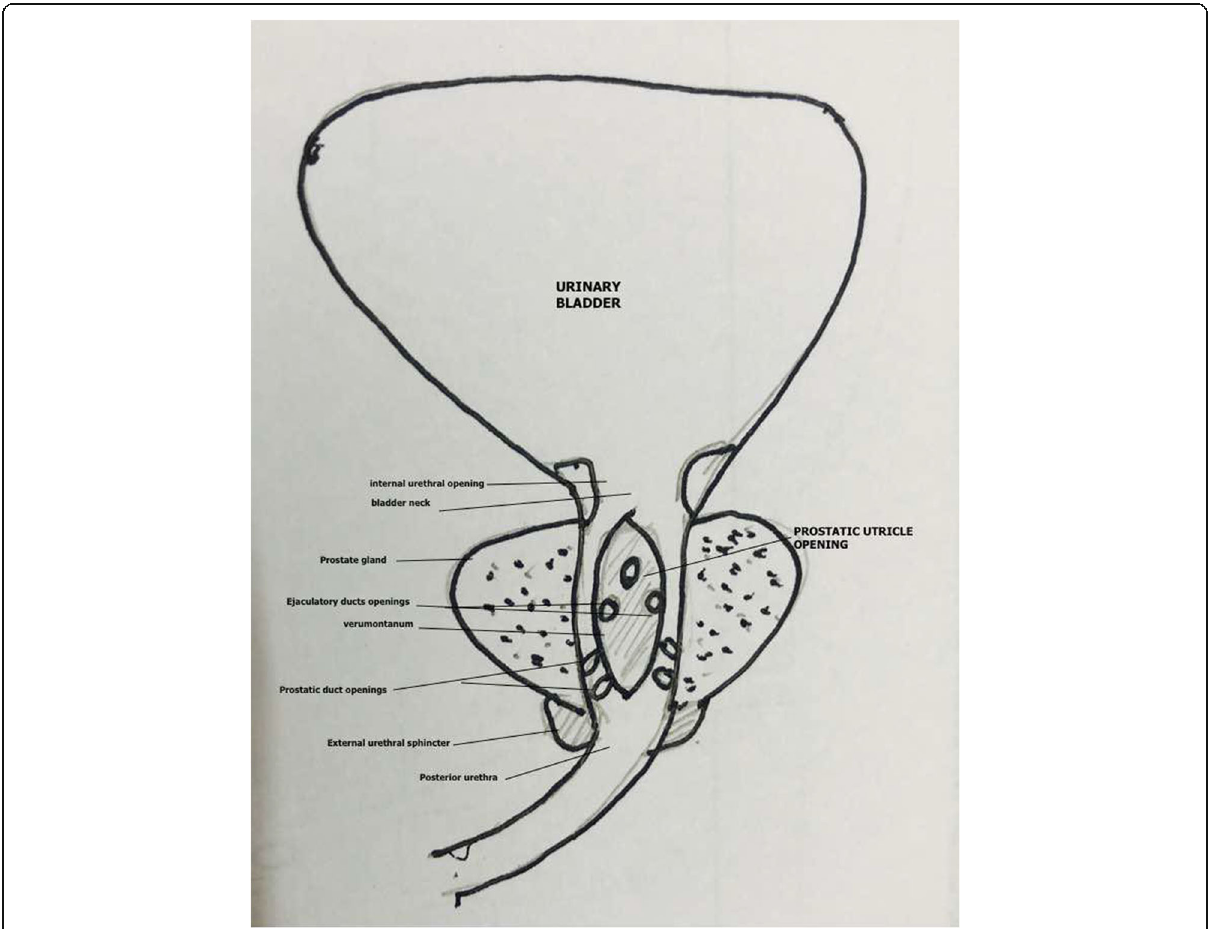
Fig. 1 Anatomy of posterior urethra showing the location of prostatic utricle (PU)